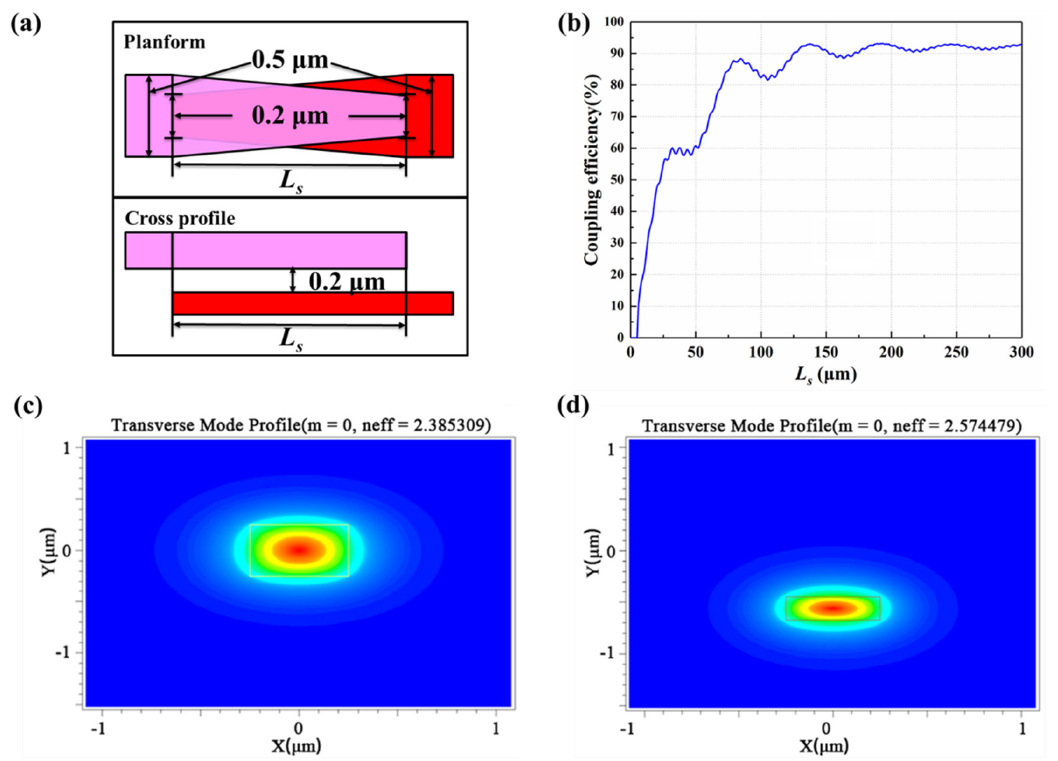
Figure 6. ( a ) The bidirectional taper structure between the InP and Si waveguide. ( b ) The relationship between the transmission and the length ( L s ) of the bidirectional taper structure. The cross-section optical field distribution of ( c ) the InP waveguide and ( d ) the Si waveguide.